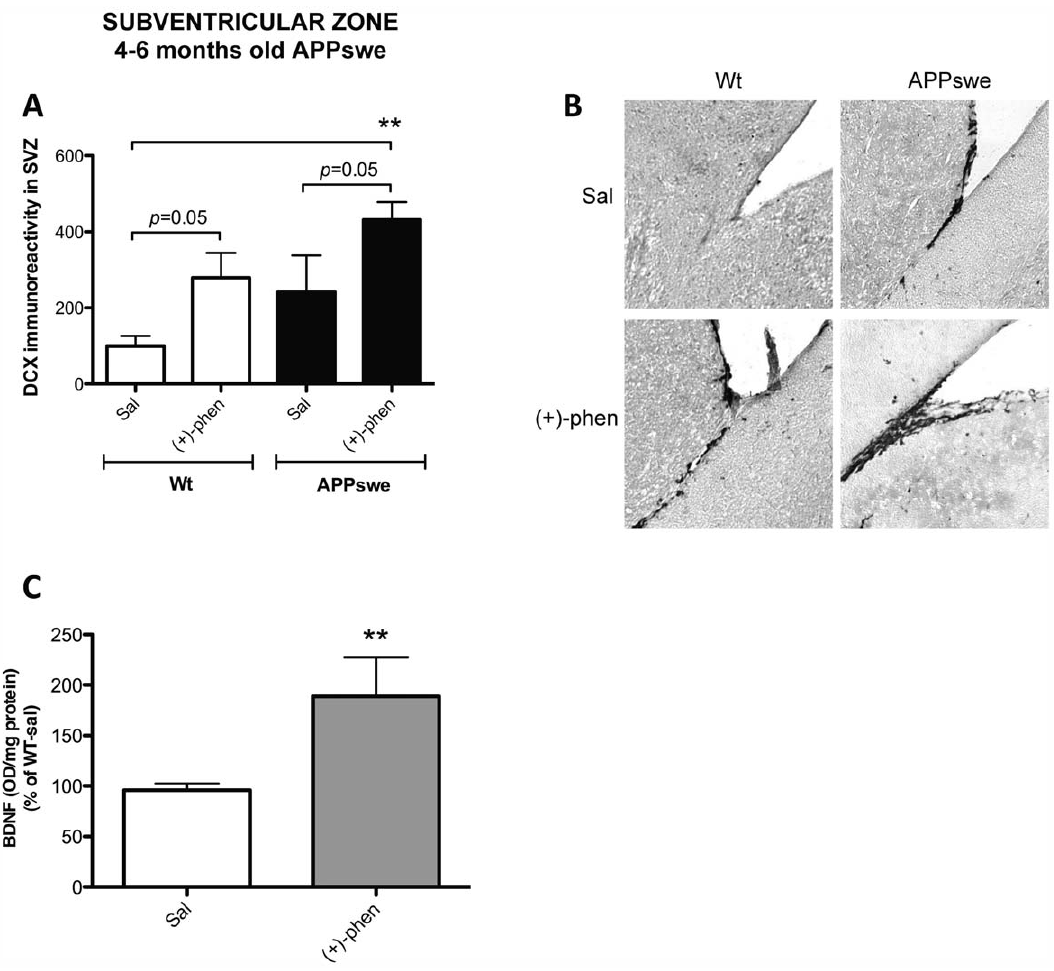
Figure 5. Enhanced doublecortin reactivity in the SVZ of 4–6 months old APPswe mice after ( + )-phenserine treatment. Doublecortin (DCX) immunoreactivity in the subventricular zone (SVZ) in 4–6 months old mice are shown in A and B. Cortical BDNF levels in wt 4–6 months old mice are shown in C. **p , 0.01 compared to wt mice treated with saline. Results are expressed as mean 6 SEM.